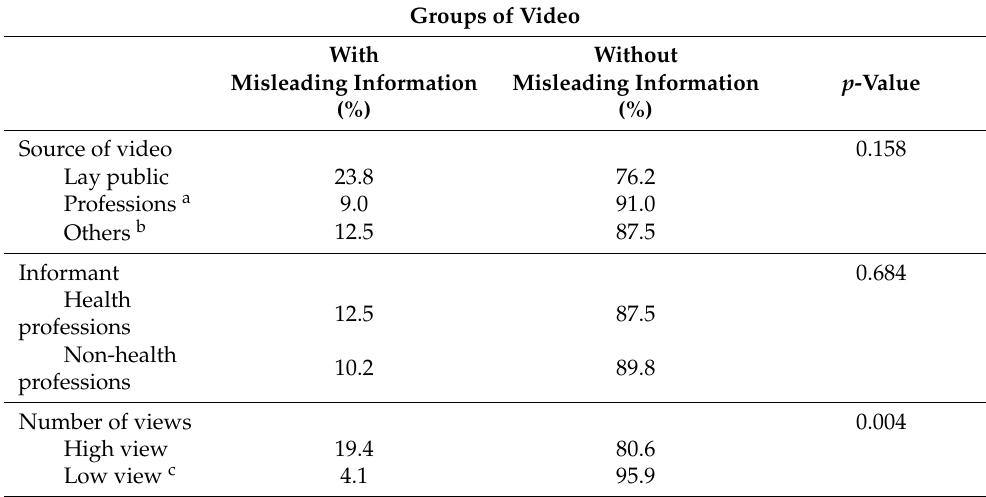
Table 11. Proportion (%) of videos with misleading information according to different video features. Groups of